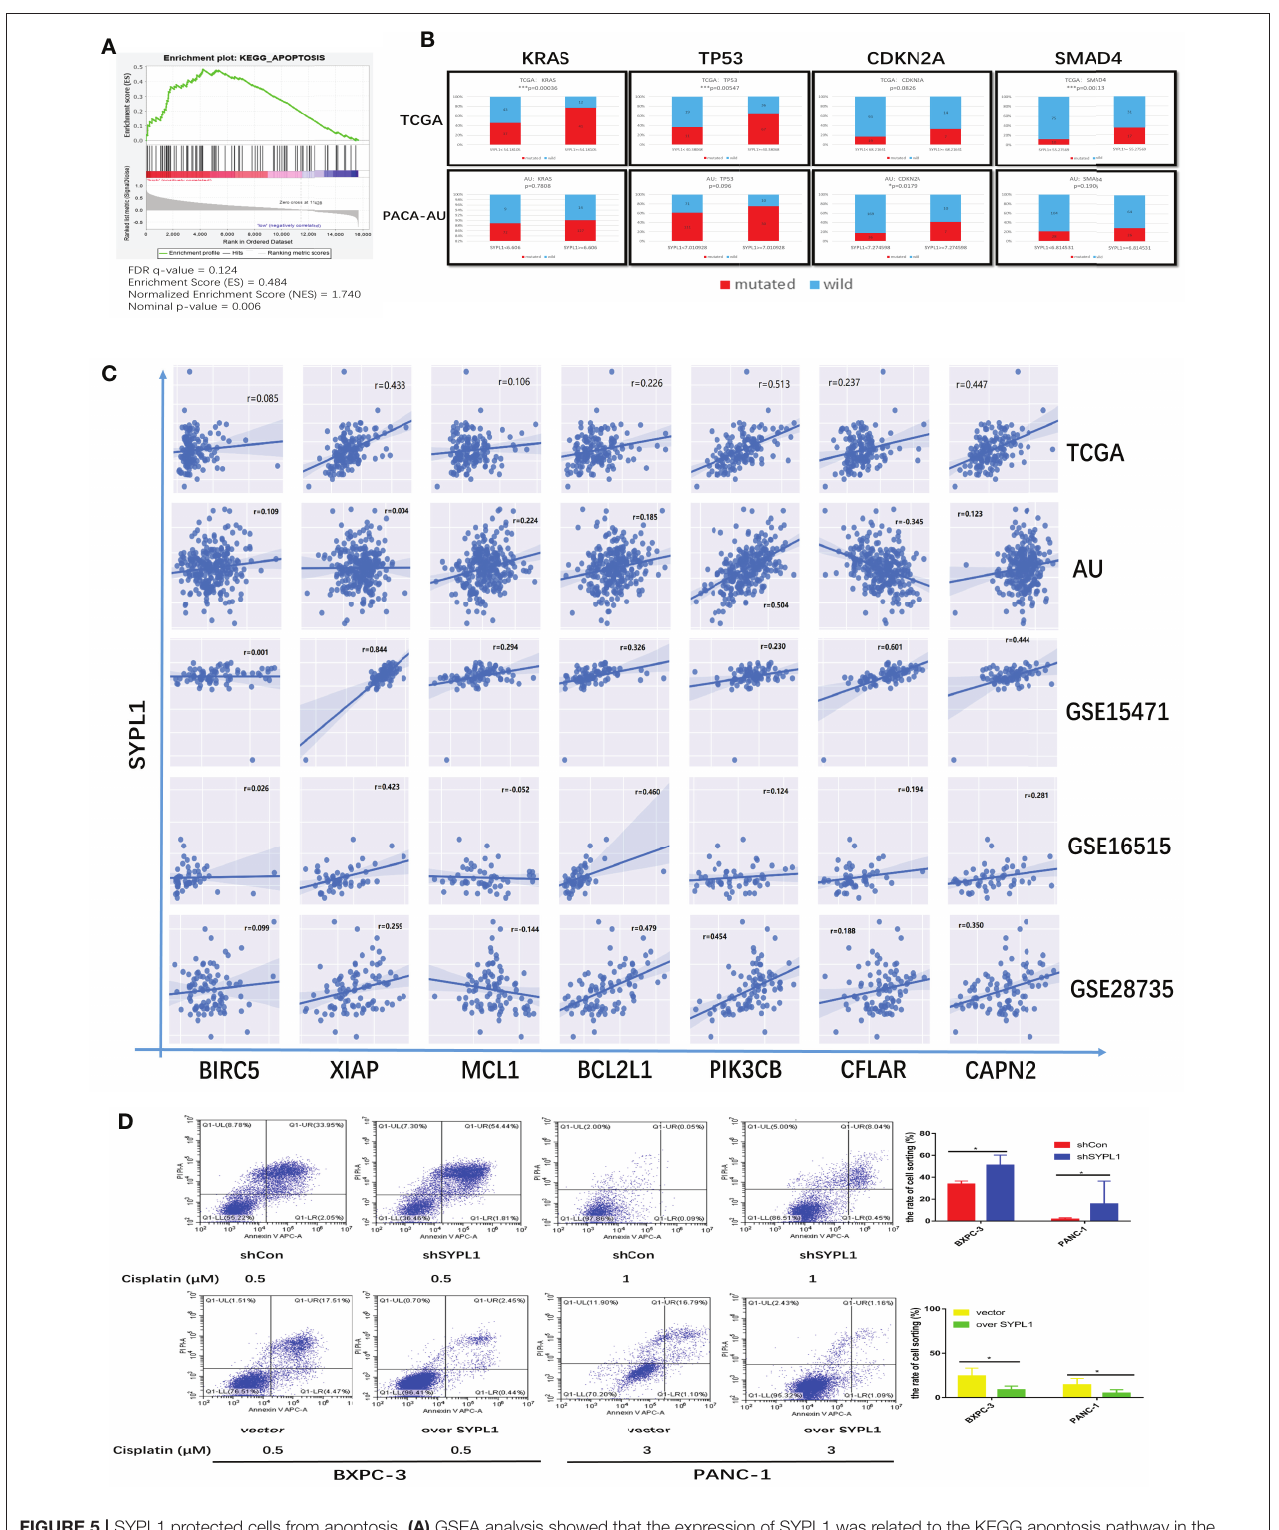
FIGURE 5 | SYPL1 protected cells from apoptosis. (A) GSEA analysis showed that the expression of SYPL1 was related to the KEGG apoptosis pathway in the TCGA dataset. (B) In the TCGA and PACA-AU dataset, the mutation rates of KRAS, TP53, CDKN2A, and SMAD4 tended to be higher in SYPL1-high patients. (C) The expression of SYPL1 positively correlated with BIRC5, XIAP, MCL1, BCL2L1, PIK3CB, CFLAR, and CAPN2, which were reported as anti-apoptosis genes. (D) Flow cytometry showed that overexpression of SYPL1 protected cells from apoptosis, and vice versa. * p < 0.05 and ** p < 0.01.